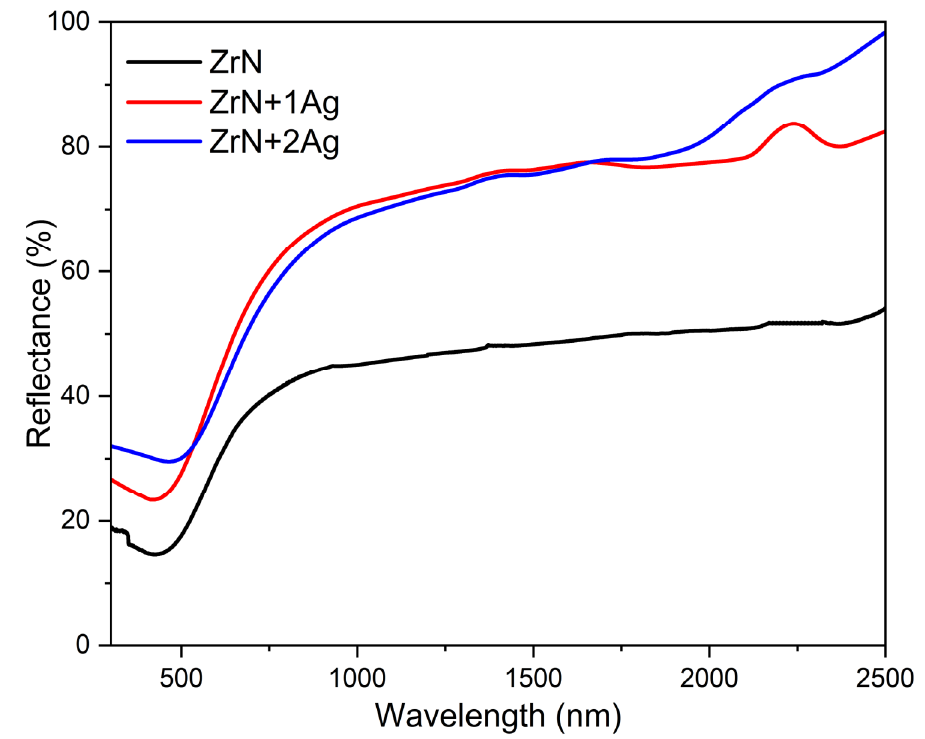
Figure 11. Reflectance spectra of the deposited coatings: ZrN, ZrN+1Ag, and ZrN+2Ag.